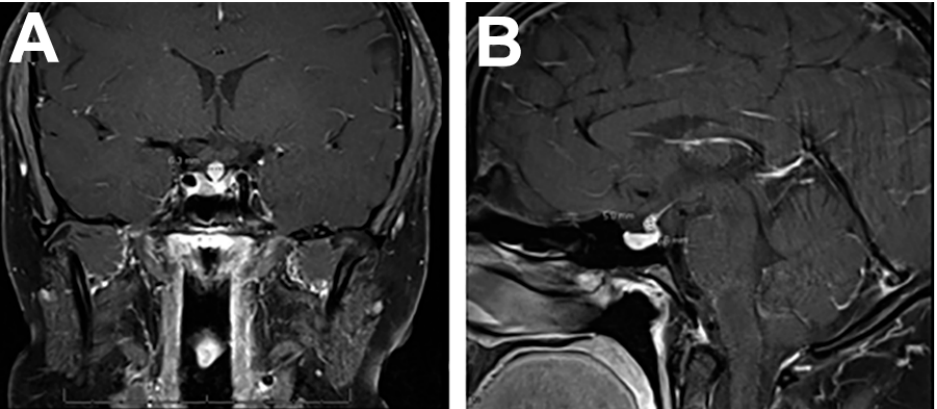
Figure 2. Coronal ( A ) and sagittal ( B ) T1-weighted MRI of a patient who initially presented with diabetes insipidus, showing focal nodular thickening and enhancement of the pituitary infundibulum with absence of neurohypophysis T1 signal. Biopsy and pathology found T cell predominant mixed in fl ammatory in fi ltrate. The clinicoradiologic picture was consistent with lymphocytic hypophysitis.